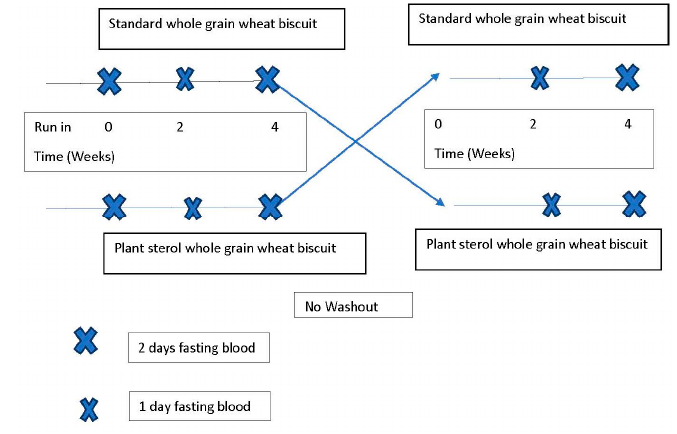
Figure 1. Study design.